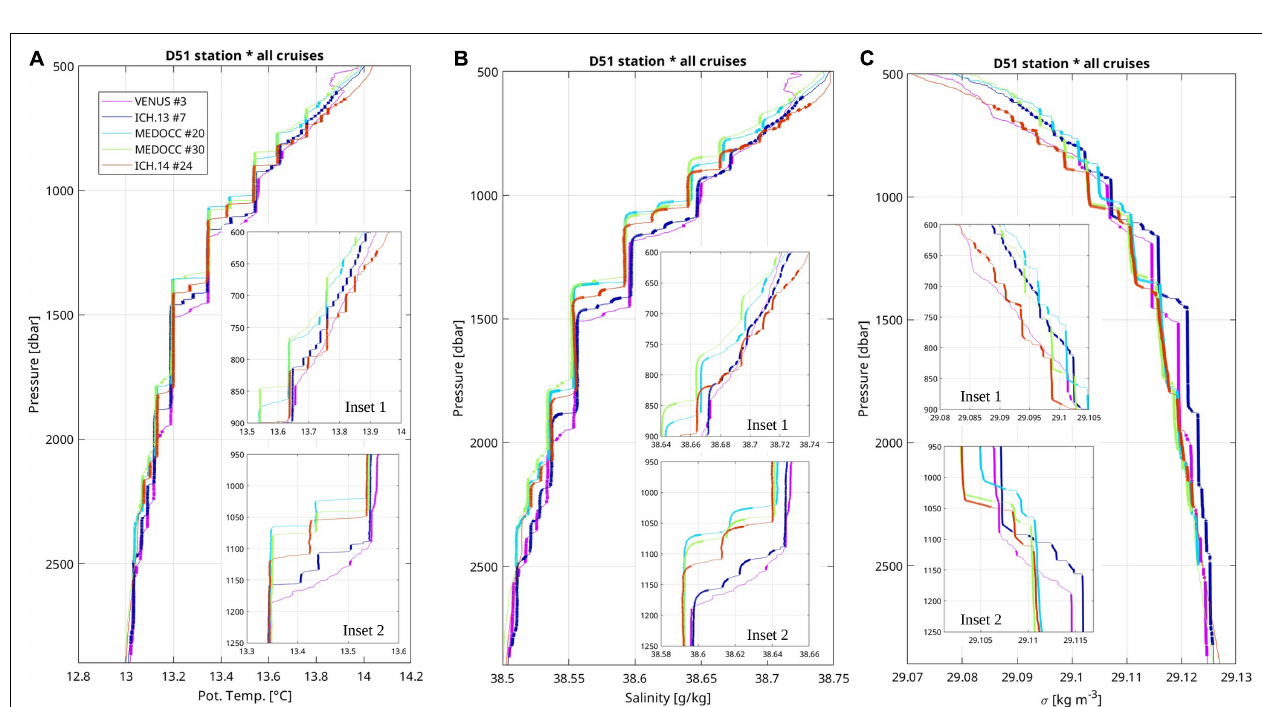
FIGURE 5 | Repeated vertical profiles of (A) potential temperature, (B) salinity, and (C) potential density at the D51 station located in the Tyrrhenian sea during four cruises in 2013–2014. Cruise names are indicated in the legend. Note that two realizations were done during the MEDOCC 2014 spring cruise. The D51 station is located on the map ( Figure 1 ). Layers are emphasized by thick lines with weak vertical gradient segments. Insets 1 and 2 shows enlargements of the profile.